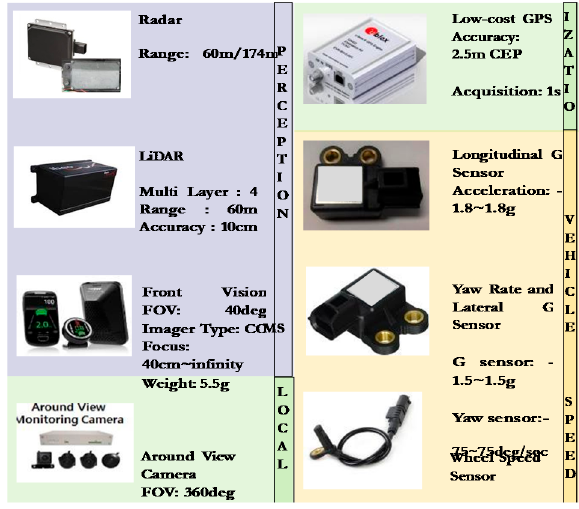
Figure 10. Sensors of autonomous driving system.